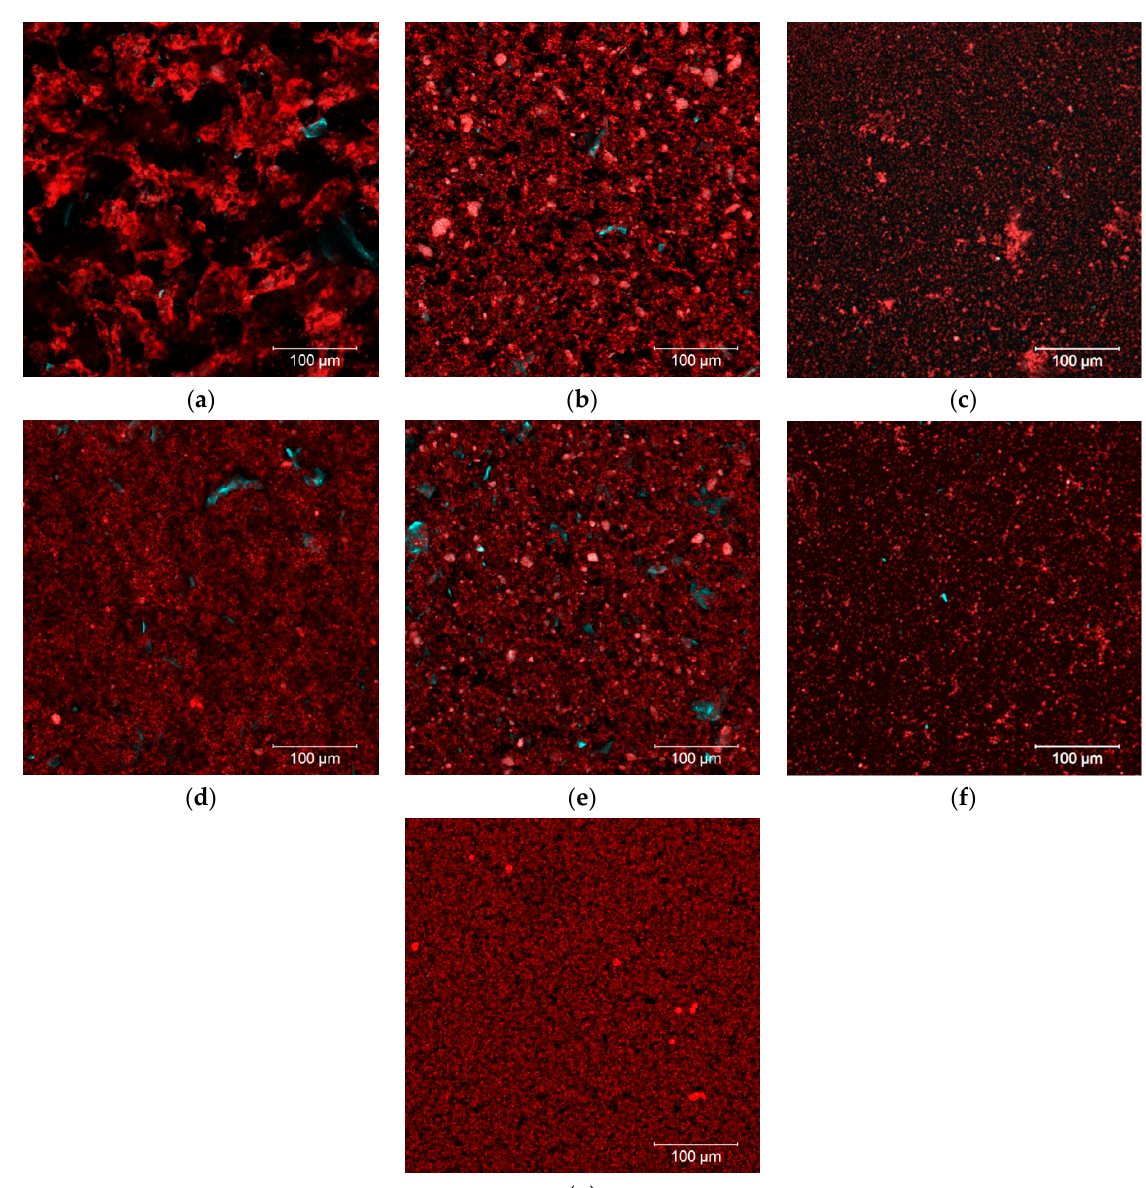
Figure 6. CLSM images of acid milk gels enriched with OBC ( a ), OBC-Hyd ( b ), OBC-Sol ( c ), OBC-M ( d ), OBC-Hyd-M ( e ), OBC-Sol-M ( f ) and the control acid milk gel (without any oat sample) ( g ). Proteins and fiber are stained with Rhodamine B (appears red) and Calcofluor White (appears cyan), respectively. The brightness of ( c , f ) was adjusted for better visualization of the protein matrix. OBC: Oat bran concentrate; OBC-Hyd: OBC hydrolyzed with β -glucanase; OBC-Sol: water-soluble fraction from OBC after hydrolysis with β -glucanase; OBC-M: OBC microfluidized; OBC-Hyd-M: OBC-Hyd microfluidized; OBC-Sol-M: OBC-Sol microfluidized.